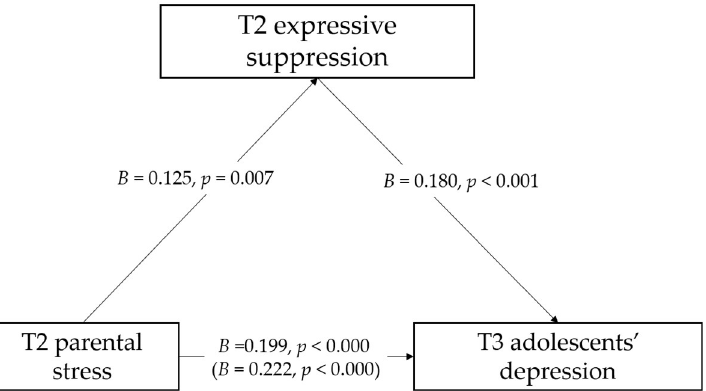
Figure 2. The mediation role of T2 expressive suppression in the association between T2 parental stress and T3 adolescents’ depression. Note: The sociodemographic variables and adolescents’ anxiety and depression symptoms to quarantine at T1 and T2 on the mediator and outcome are controlled for but are not shown for simplicity. Slope coefficients are unstandardized. Values in brackets refer to the total effect of T2 parental stress on T3 adolescents’ depression without including the mediator.